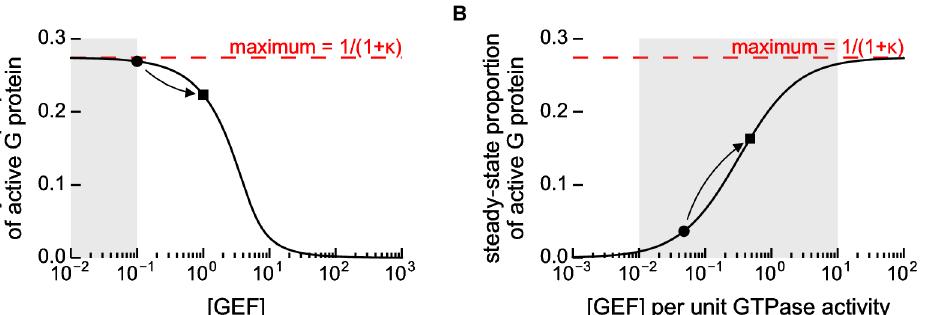
Fig 3. GTPase activity restores the ability of GEFs to positively regulate a G protein by moving the system away from equilibrium. The relationship between the concentration of GEF and the steady-state proportion of active G protein. The concentration of active G protein cannot increase above a theoretical maximum proportion derived from the ratio of the total backwards and forwards catalytic rates of the GEF ( κ ). The markers and arrow demonstrate the effect seen before (circle) and during (square) the stimulation shown in Fig 2D and 2E. The shaded region denotes the region which is most likely to be physiologically relevant. A In the absence of GTPase activity, Eq 5, increasing the GEF concentration can only decrease the steady-state concentration of active G protein, instead producing GEF (cid:1) G protein complexes. B In the presence of GTPase activity, Eq 7, the steady-state concentration of active G protein is suppressed. Increasing the (relative) concentration of GEF acts to counter this suppression, driving the activation state back towards the